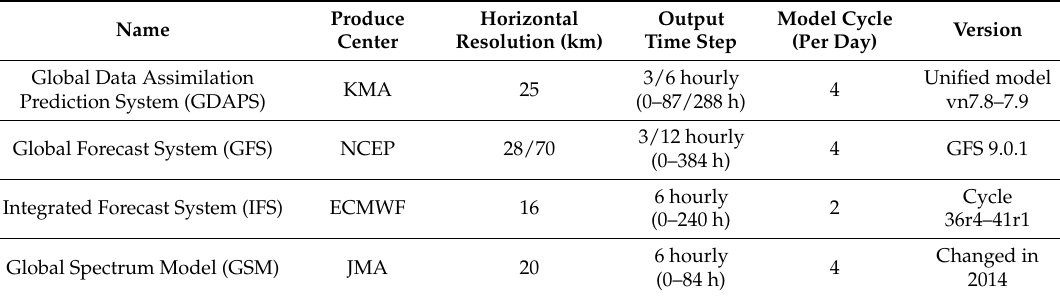
Table 1. The list of numerical models used in this